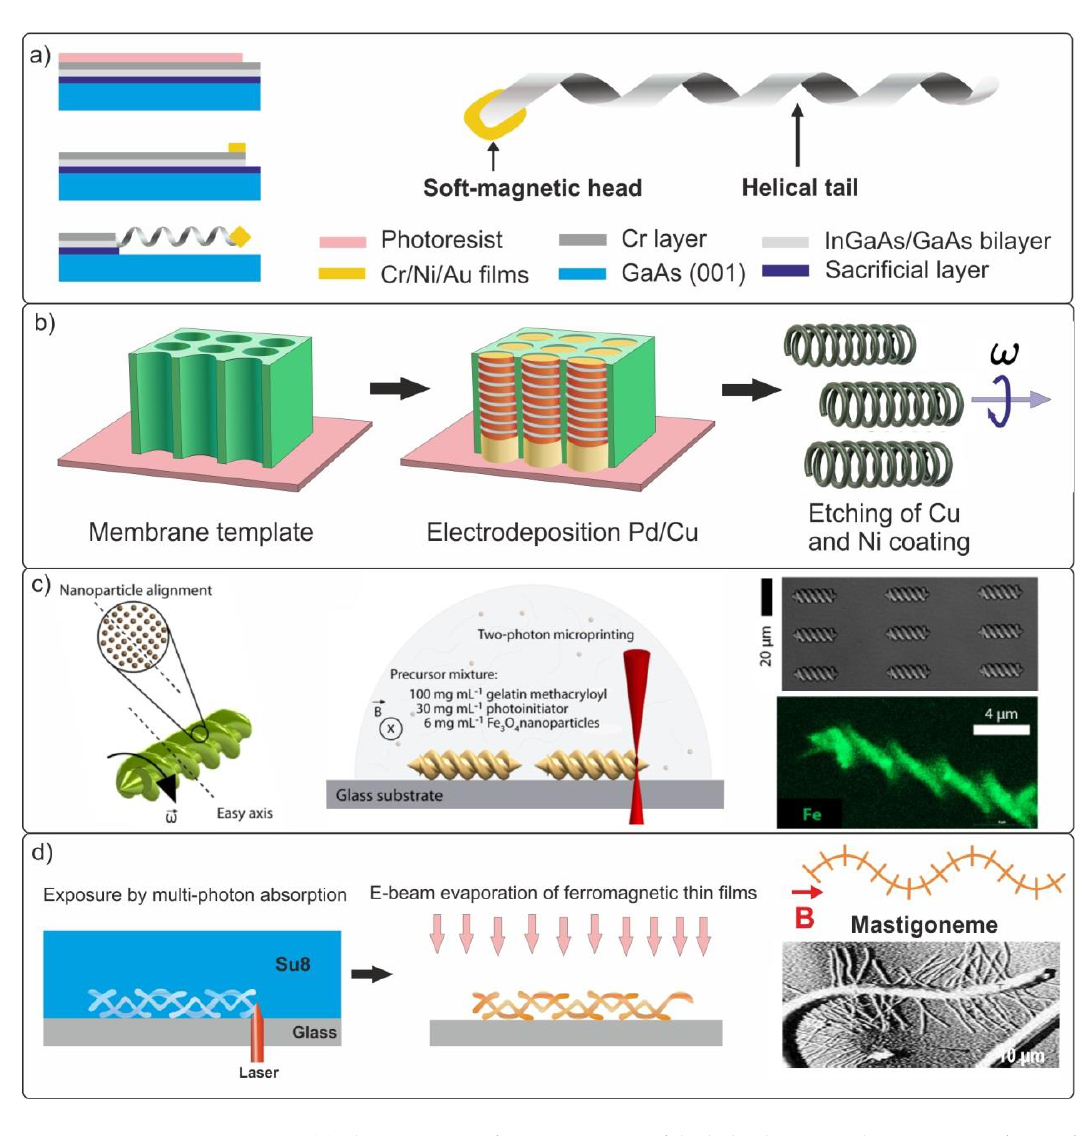
Figure 8. ( a ) The main manufacturing stages of the helical semiconductor InGaAs/GaAs/Cr swimmer. ( b ) Schematic representation of a template-based manufacturing process of helical nanoswimmers of 800 nm in length. ( c ) Manufacturing process of a 3D magnetic biodegradable swimmer using the two-photon polymerization method. Images of hydrogel microcoils obtained using optical microscopy and energy-dispersive X-ray spectroscopy [80]. ( d ) Photo of Mastigonemes of Ochromonas and the manufacturing stages of a biomimetic rigid